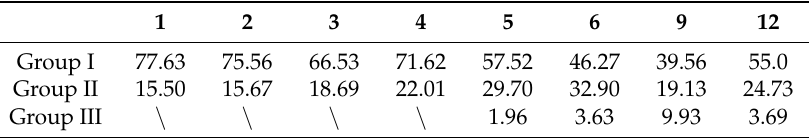
Figure 4. The changing trend of the total relative content from the 1st to 12th month of three groups of PECs which were subdivided according to the substitution pattern of phenylethyl moiety. Group I were PECs with no substitution at phenylethyl moiety, group II were PECs with 4′ -OCH 3 at phenylethyl moiety, group III were PECs with 3′ -OH and 4′ -OCH 3 at phenylethyl moiety. Table 5. The statistic results of the total relative content (%) from the 1st to 12th month of three groups of 2-(2-phenylethyl)chromones which were subdivided according to the substitution pattern of phenylethyl moiety.